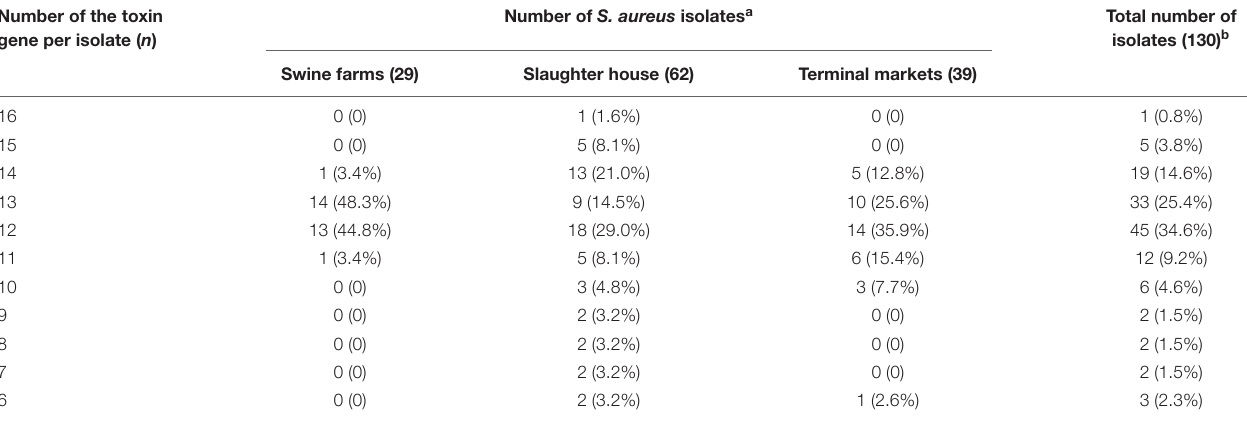
a The number in parentheses represents the percentage of isolates with the corresponding number of toxin genes for all S. aureus isolates of the same part in pork production. b The number in parentheses represents the percentage of isolates with the corresponding number of toxin genes for all S. aureus isolates.